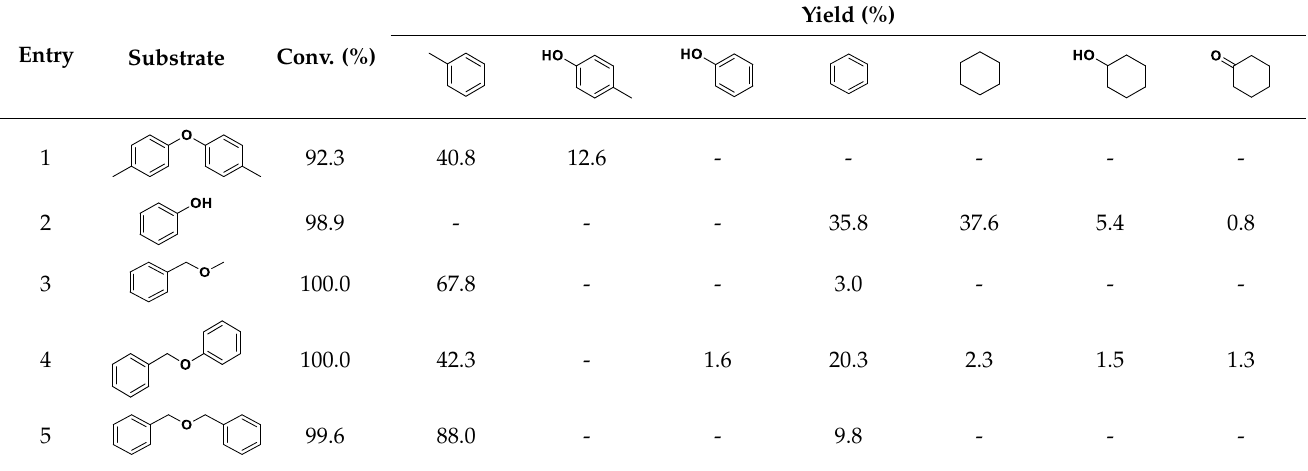
Table 3. Hydrogenolysis of different model compounds over Ru-Ni 12 P 5 /S-1 5 . Entry Substrate Conv. (%) Entry Substrate